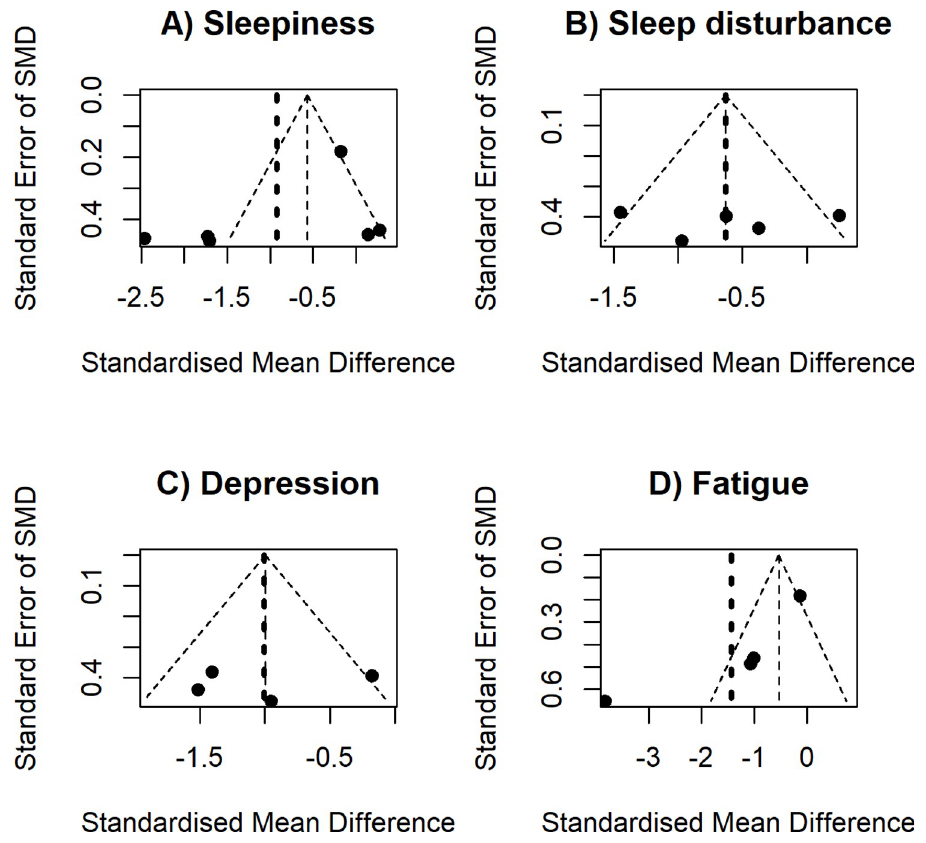
Fig 4. Funnel plot showing the relationships between behavioral symptoms reduced by BWLT and their precision. Standardized mean differences (SMDs) of behavioral symptom reduction indicate the effect estimates of Blue- Wavelength Light Therapy (BWLT) compared with control interventions. The standard errors of those SMDs express the precision. The outer dashed lines indicate the triangular region within which 95% of studies are expected to lie in the absence of both biases and heterogeneity. The bold dash line corresponds to no intervention effect. Control interventions included amber, red, or no light therapy.